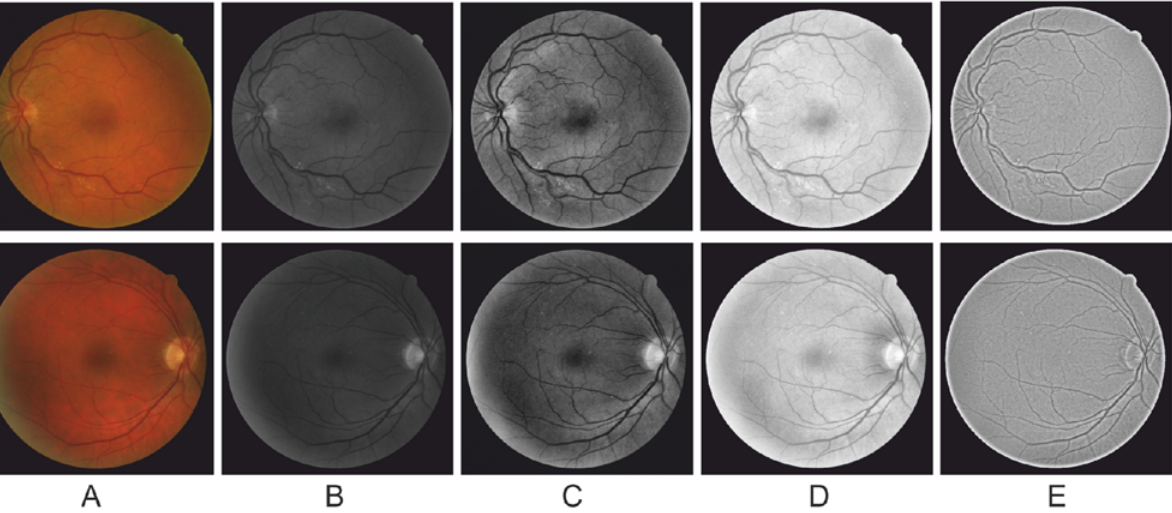
Fig 1. A comparative study on image-wise enhancement techniques. (A) Two example images from the DRIVE dataset. (B) The green channel of (A). (C) and (D) show the results of applying Histogram Equalization and Gamma correction image enhancement methods on (B), respectively. Each method enhanced image contrast: however, there still exist large areas of inhomogeneity. (E) Results after applying Retinex on (B). Retinex enhances the contrast between vessels and background well, and in consequence the vessels are more easily identifiable.